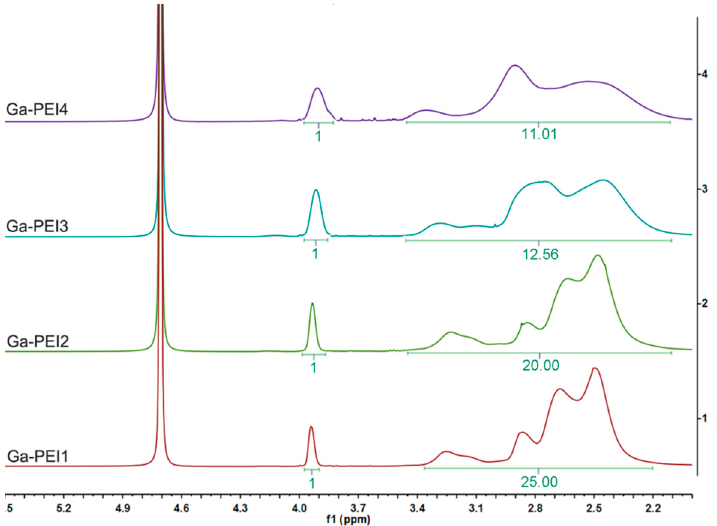
Figure 1. 1 H NMR spectra of Ga-PEI. The degree of substitution (DS) could be calculated by the ratio between the peak areas. The singlet of δ 3.9 ppm represents C H 2 OH on the substituents, while the broad multiplet represents the C– H near the amino groups of PEI. Table 1. Characterization of the polymers. DS was obtained from 1 H NMR and represents the DS of the entire amino groups in PEI. M w and polydispersity (PDI) were obtained from GPC.